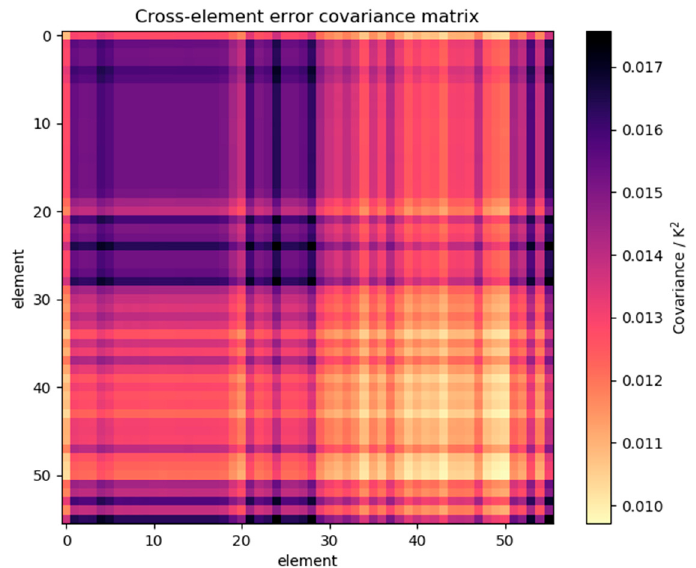
Figure 2. Cross-element error covariance matrix calculated for the scan line through point ‘A’ of Figure 1. HIRS scans such that element indices 0 to 55 run from east to west (right to left) in Figure 1. The range of the colour scale corresponds to brightness temperature uncertainty from 0.10 K to 0.13 K. The matrix shown gives the error covariance from structured effects.